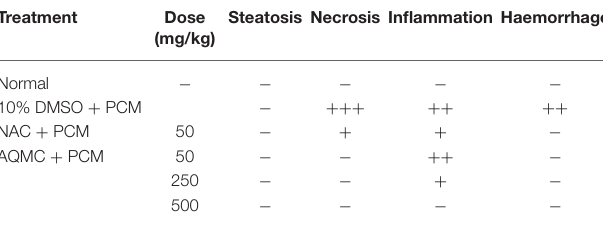
TABLE 6 | Histopathological scoring of PCM-intoxicated rat’s liver tissue following pretreatment with AQMC at the doses ranging between 50 and 500 mg/kg. Treatment